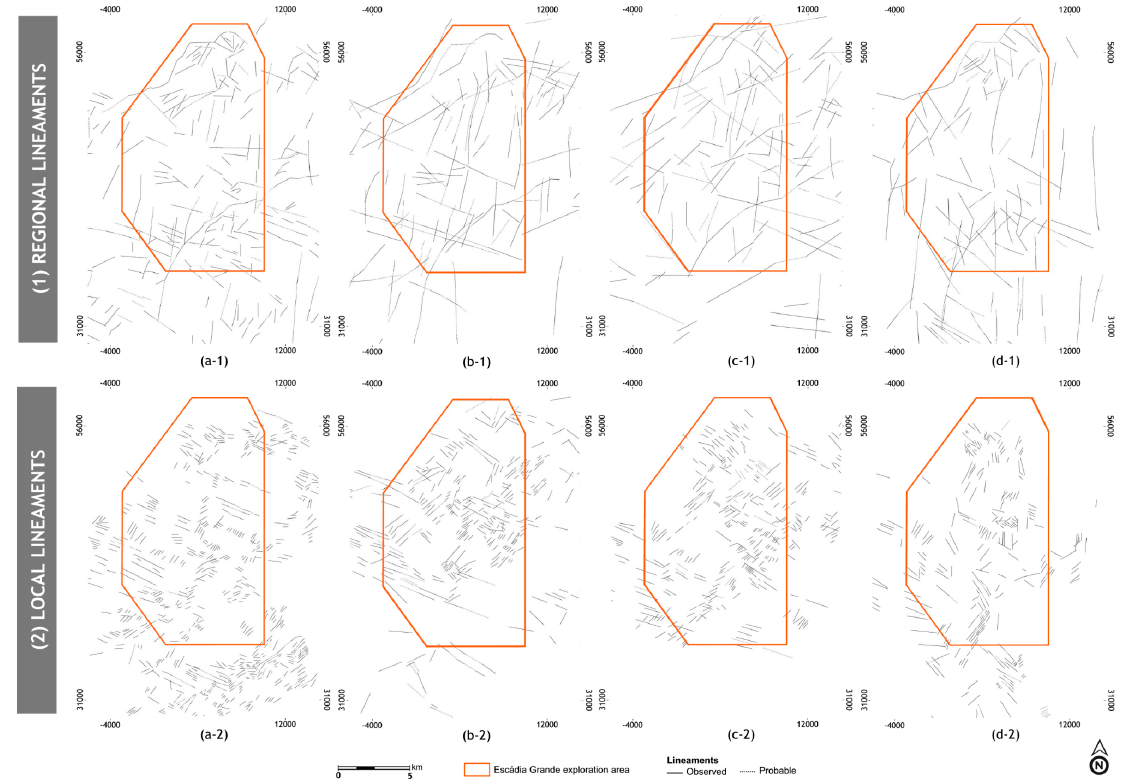
Figure 12. Lineament reinterpretation based on: ( a ) Landsat 8 (RGB colour composites); ( b ) Landsat 8 (directional filters—OLI band 6); ( c ) Landsat 8 (directional filters—band ratios) and ( d ) hill shade relief maps. ( 1 ) Regional lineaments. ( 2 ) Local lineaments.